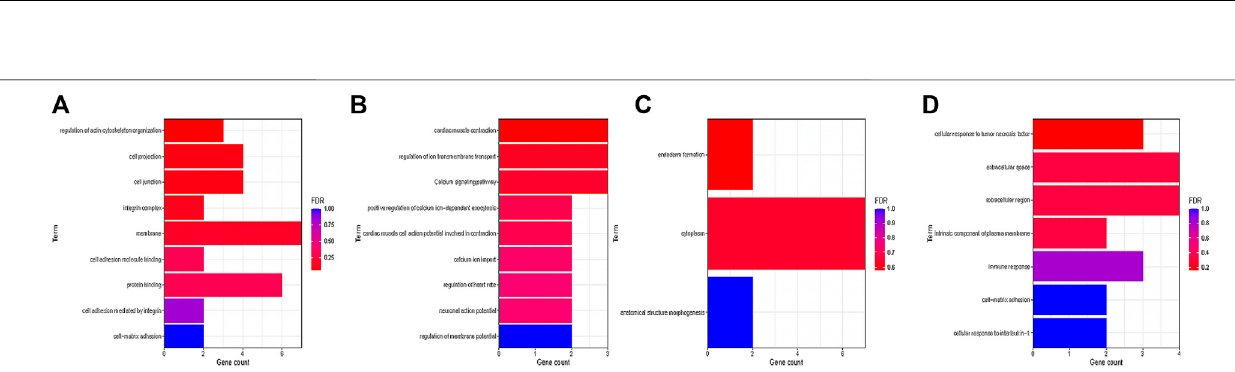
Frontiers in Genetics |